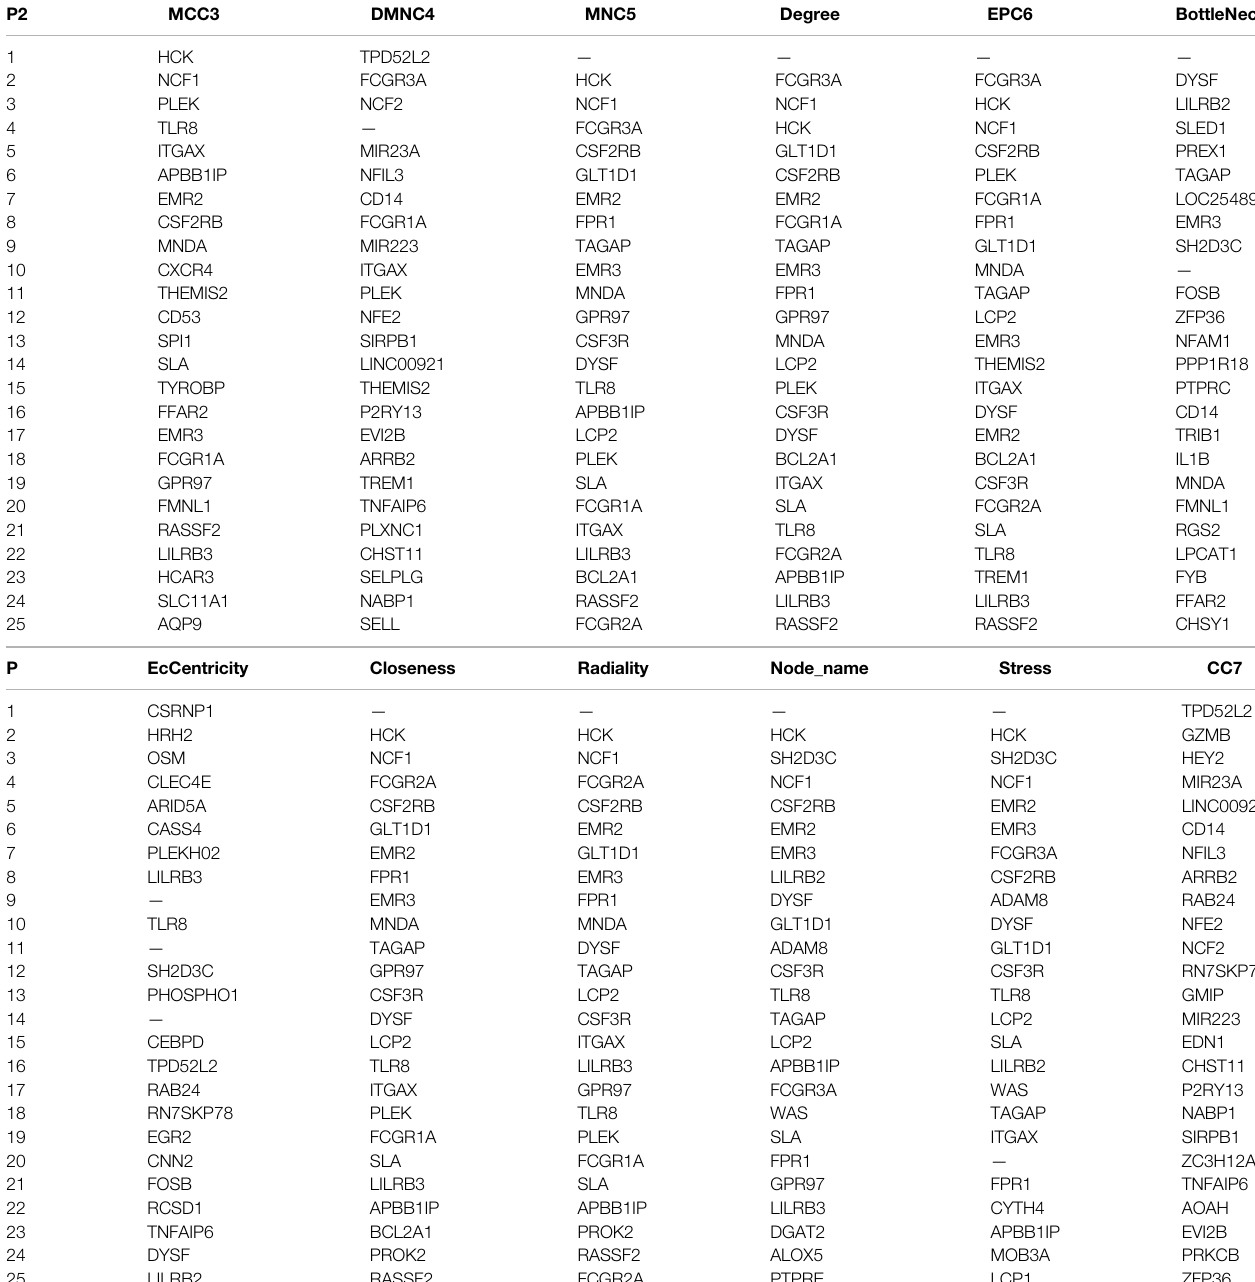
TABLE 2 | Top 25 hub genes of the brown module through dataset